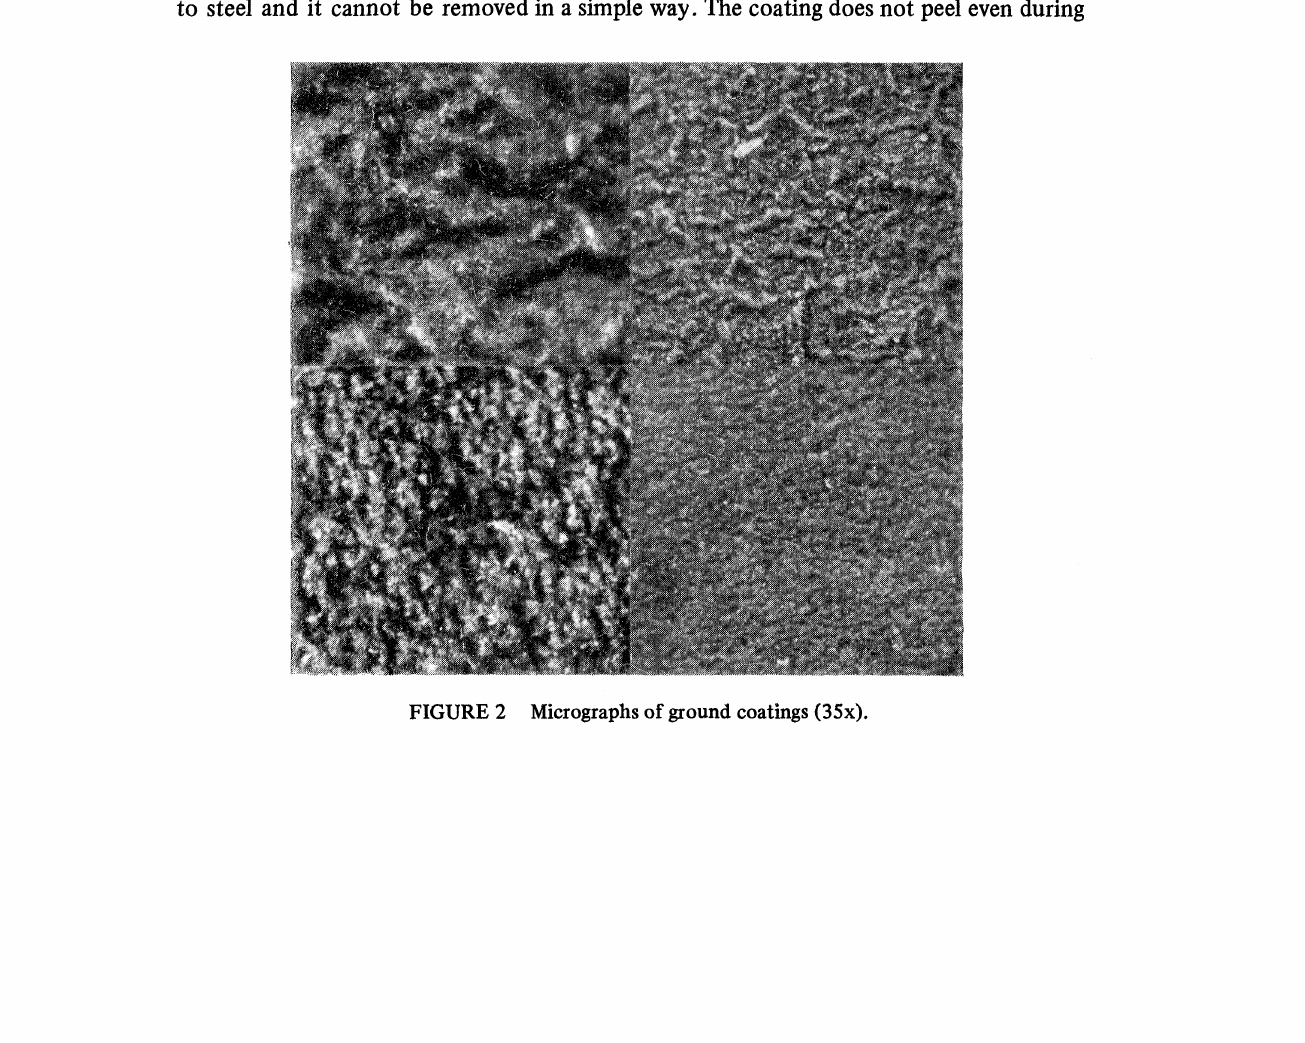
FIGURE Steel substrates coated with (from the left) glass powder, ground coating and final ceramic coating. 1) The coating is dull till folded as per the amount of glass powder applied to the steel surface (see Figure 2). Due to this reason, the thickness of the coating is difficult to determine. Its colour changes from dark grey to light grey according to the firing tem- perature. The melting temperature of the coating is not estimated but it is higher than 1,100C.